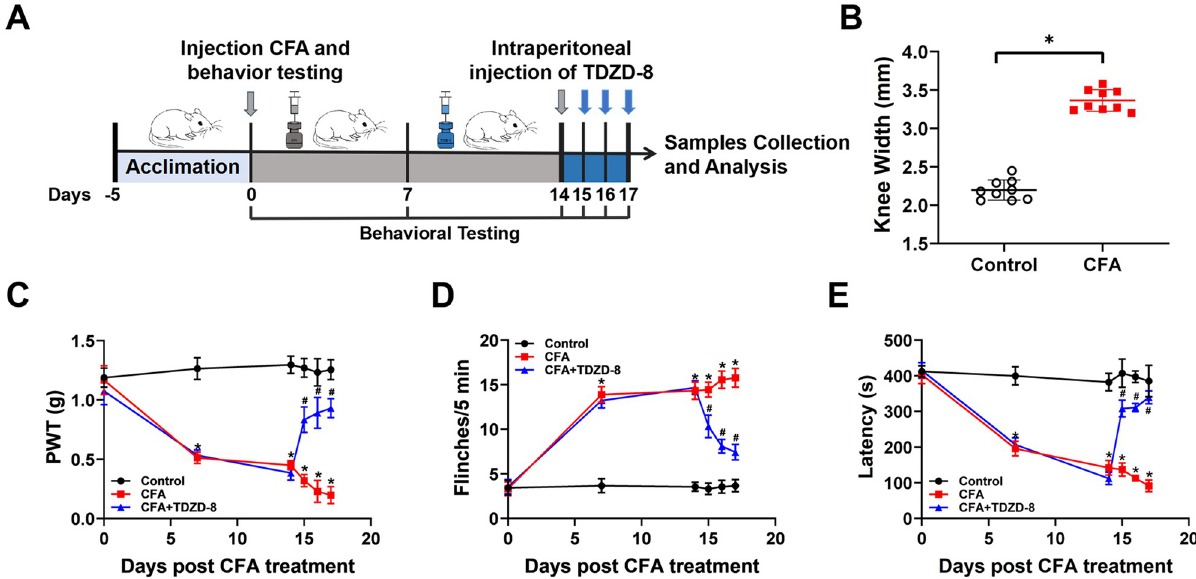
Fig 1. Effect of TDZD-8 treatment on pain behaviors of CFA-induced mice. (A) Schematic diagram of the experimental procedures. On day 0, CFA was intra-articularly injected into the left knee joint of mice, and behavioral tests were conducted at day 0, 7, and 14. TDZD-8 was intraperitoneally injected in mice on day 15, 16 and 17. After 4 h of TDZD-8 treatment, behavioral tests were conducted. Subsequently mice were sacrificed and spinal cord tissues were collected for the further analysis. (B) Changes of knee width of control and CFA mice on day 14 after CFA inducement. Changes of PWT values (C) spontaneous flinches (D) and latency (E) to fall of mice. Data are expressed as the mean ± SEM (n = 9). * P < 0.05 vs . control group, # P < 0.05 vs . CFA